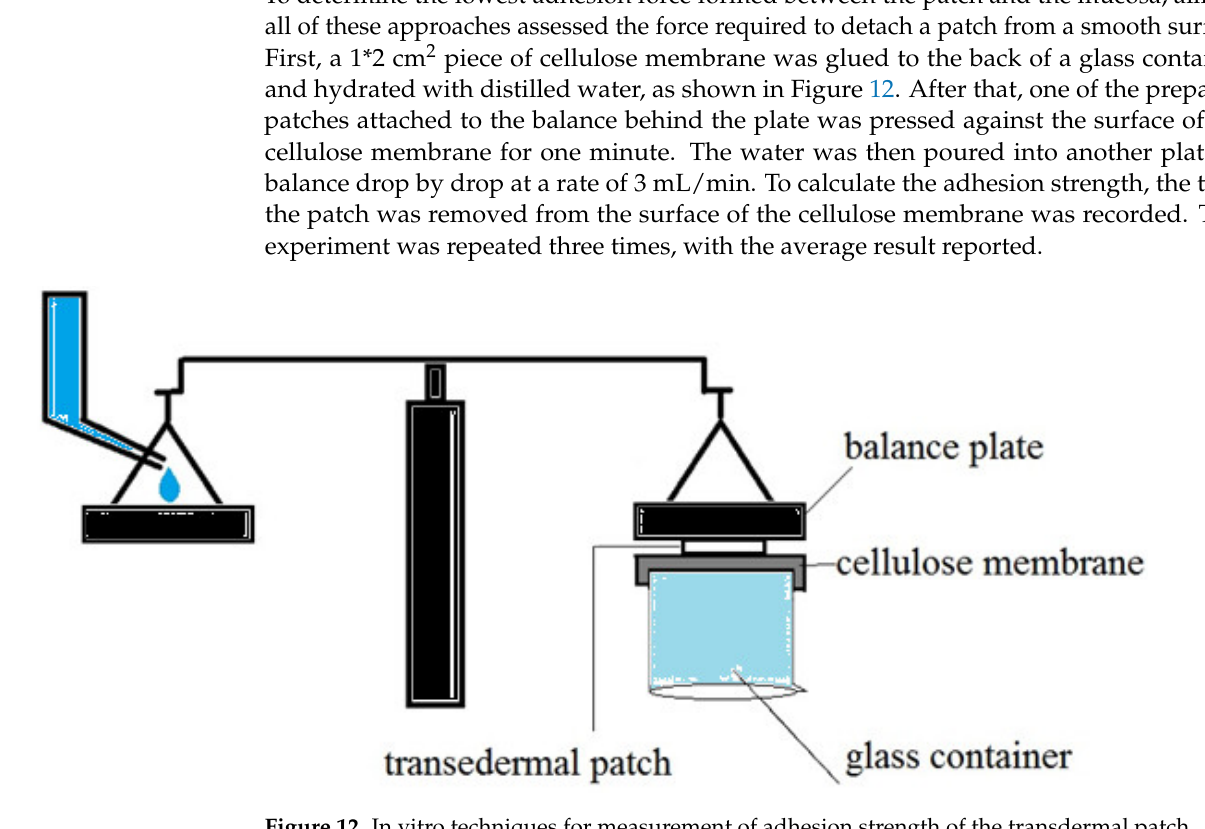
Figure 12. In vitro techniques for measurement of adhesion strength of the transdermal